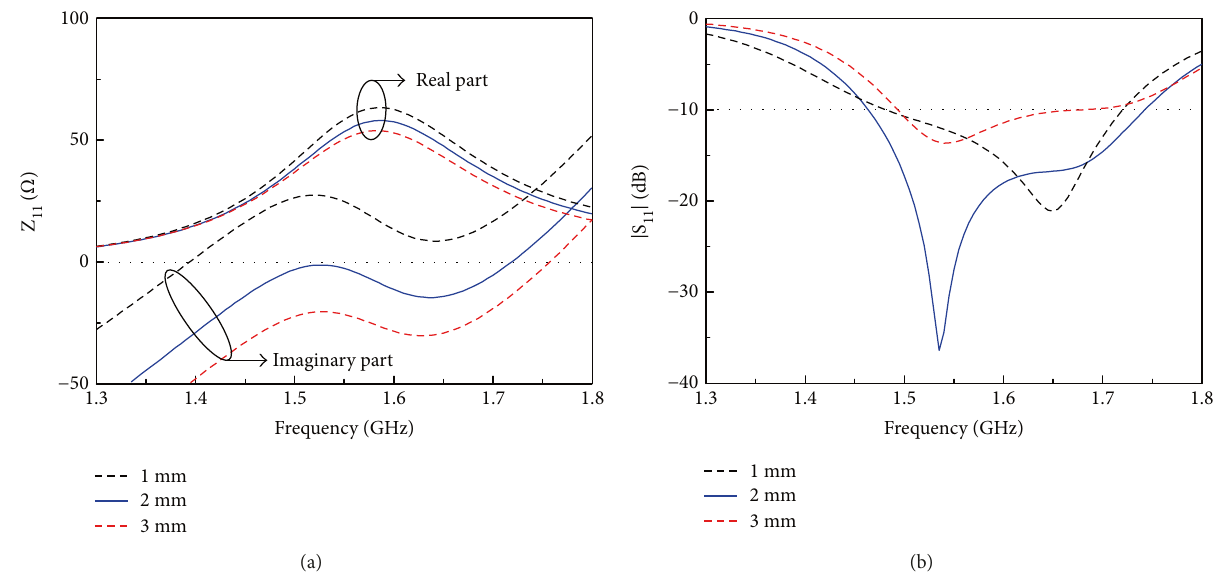
Figure 9: Simulated (a) input impedance and (b) |S between the dipole radiator and the parasitic patch ( H